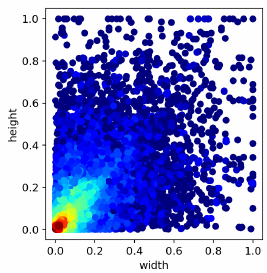
Figure 7. Target Size Heat Map.